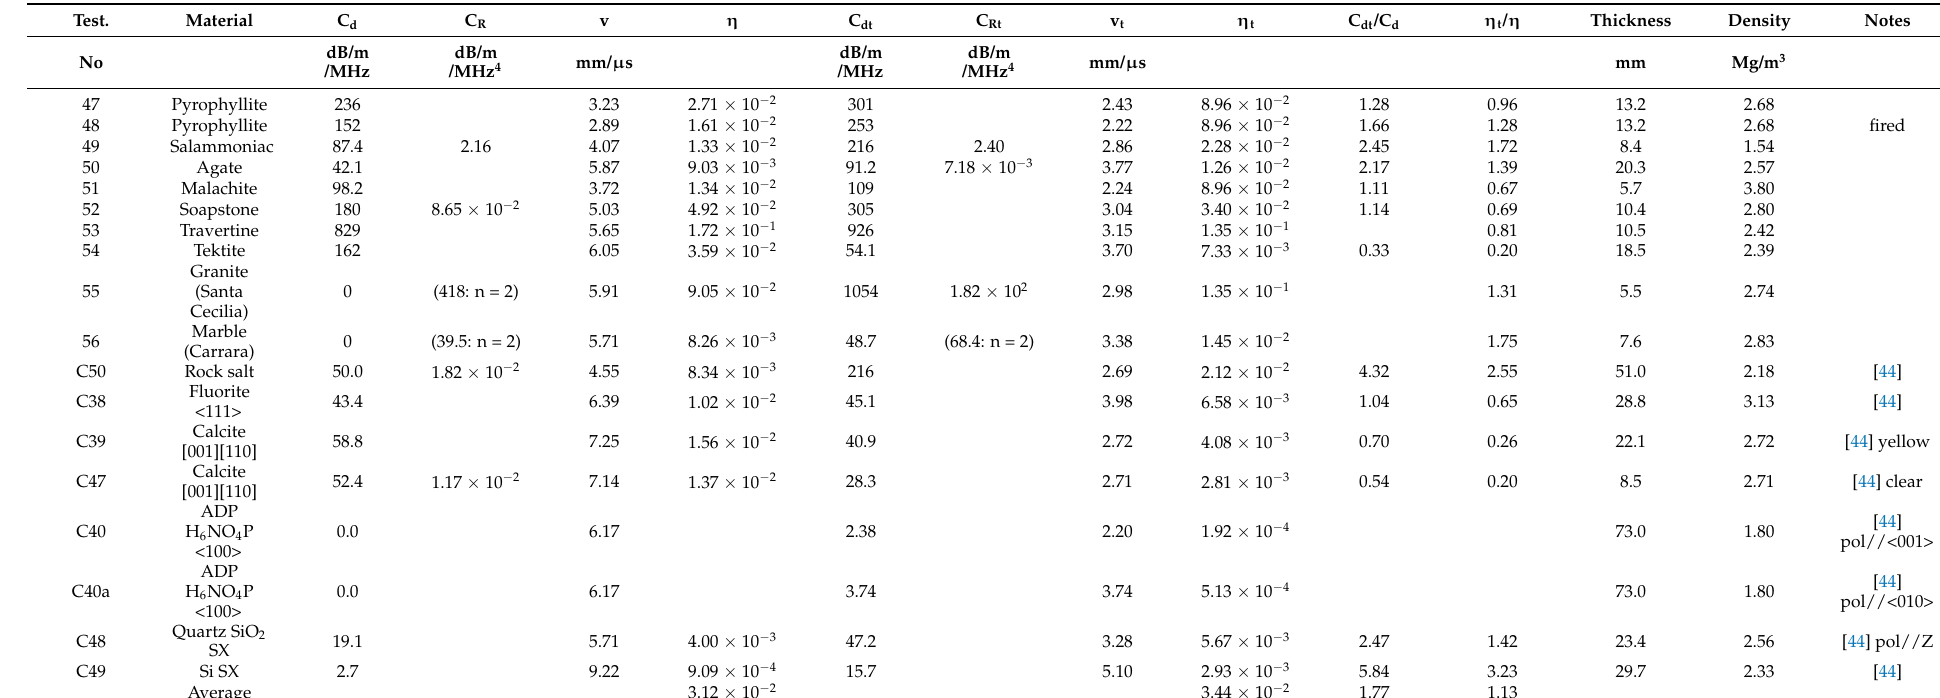
Table 7. Attenuation coefficients of longitudinal and transverse modes of rocks and single